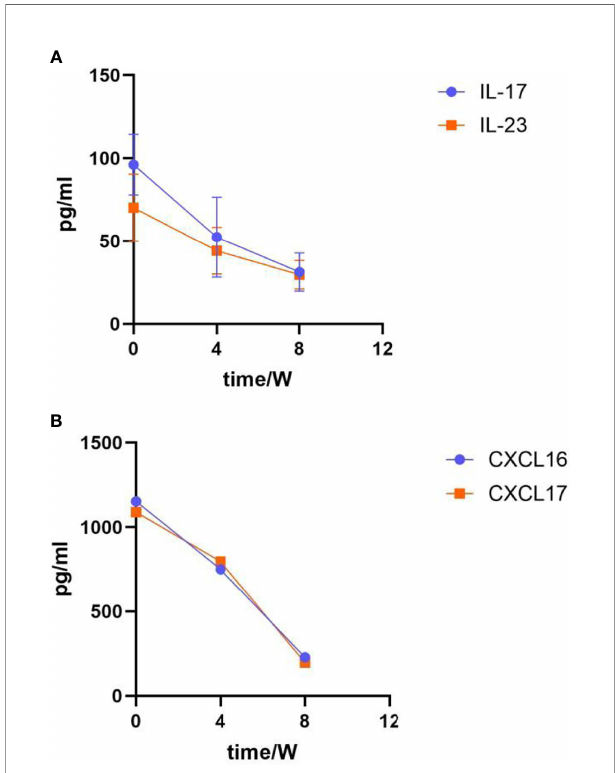
FIGURE 2 | Laboratory indicators after guselkumab treatment. (A) Changes in IL- 17 and IL-23 expression levels. The expression of IL-17 at baseline was (96.14 ± 18.35); Week 4 was (52.44 ± 24.12), Week 8 was (31.27 ± 11.54); The expression of IL-23 at baseline was (70.13 ± 20.26), Week 4 was (44.20 ± 14.19), Week 8 was (29.65 ± 8.64). (B) Changes in CXCL16 and CXCL17 expression level. The expression of CXCL16 at baseline was (1153.32 ± 25.53); Week 4 was (750.38 ±